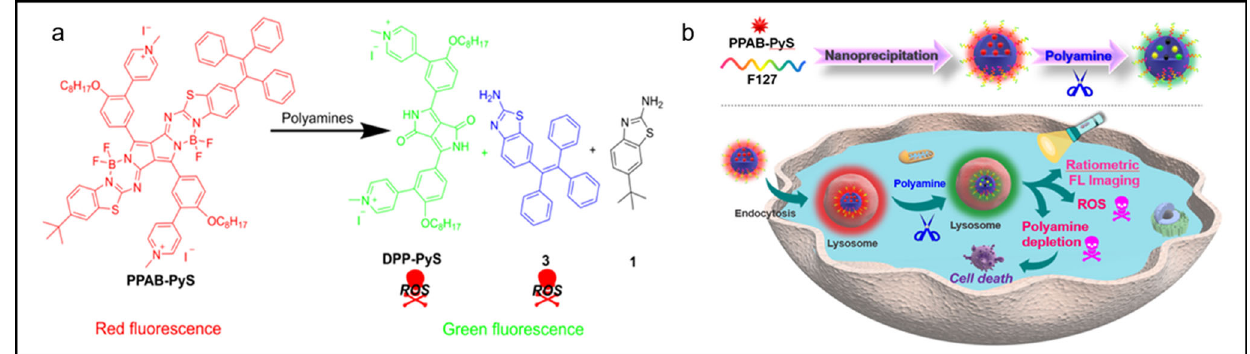
Fig. 1 The combination of photodynamic therapy with a putative depletion of polyamines on cancer treatment. a The proposed reaction between PPAB- PyS and polyamines. b Schematic illustration of lysosome-targeting, polyamine depletion, enhanced ROS generation, and ratiometric fl uorescence imaging for the cancer cells.